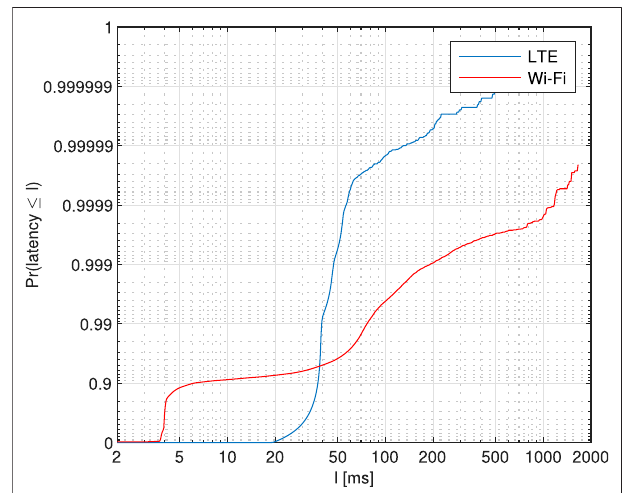
FIGURE 5 | Empirical latency CDFs of considered